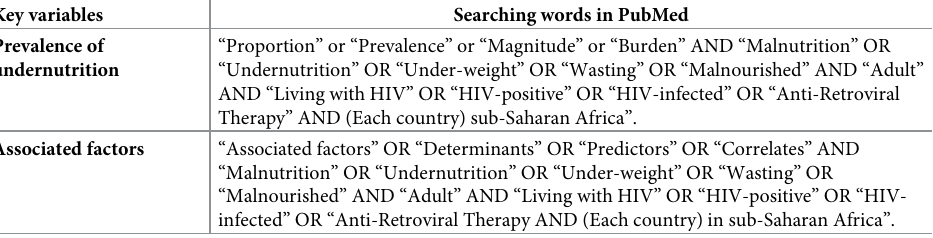
Table 1. The search strategy used in the PubMed database,